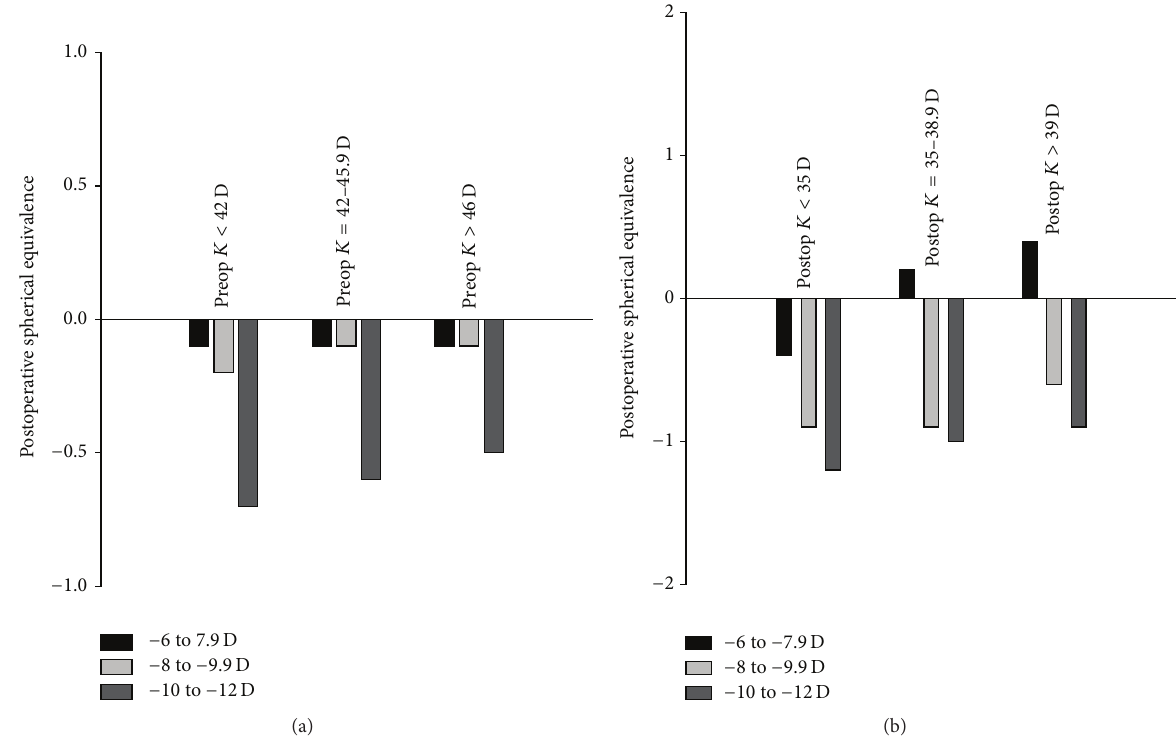
Figure 1: Postoperative spherical equivalence stratified by pre- and postoperative keratometry, respectively.